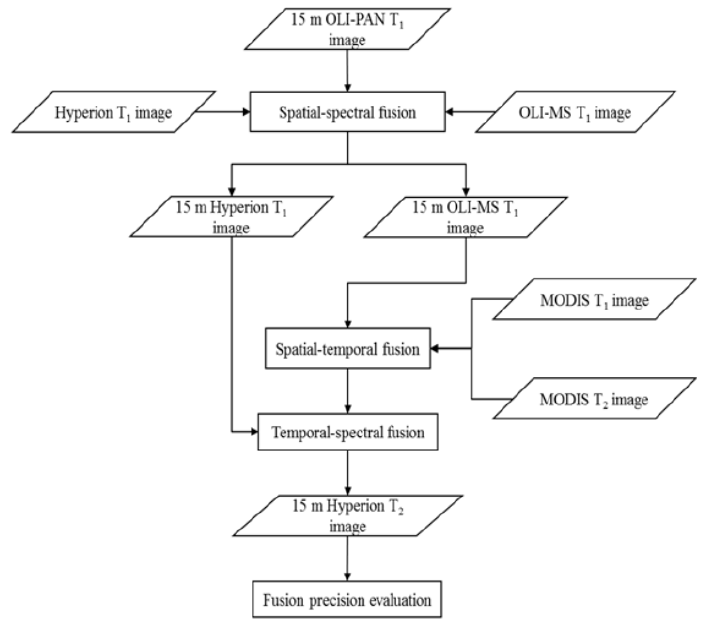
Figure 6. Workflow of hybrid s patio ‐ temporal–spectral fusion model